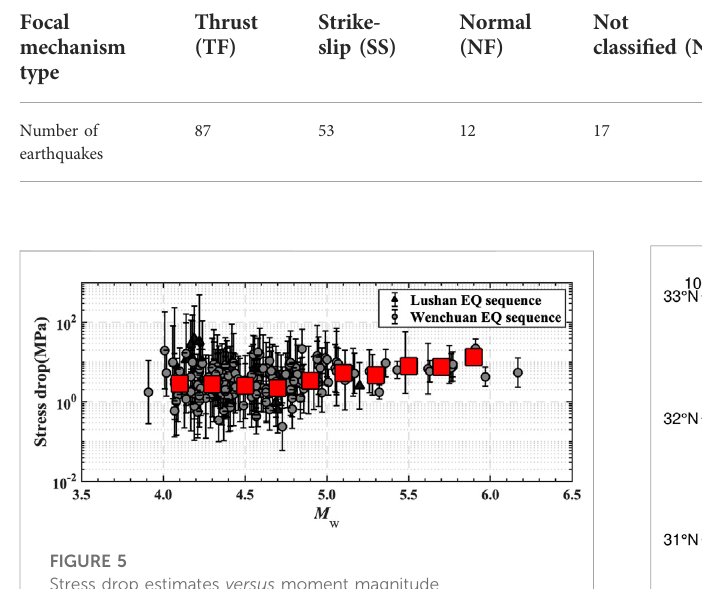
TABLE 1 Summary of the grouping of the focal mechanism solutions for the analysed events using the classi fi cation of Zoback (1992).